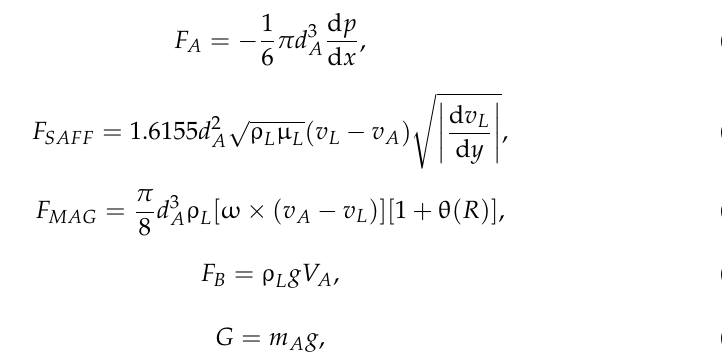
Figure 4. Wear mechanism. From the above assumptions, the equation for abrasive wear based on the Archard model can be obtained as follows: